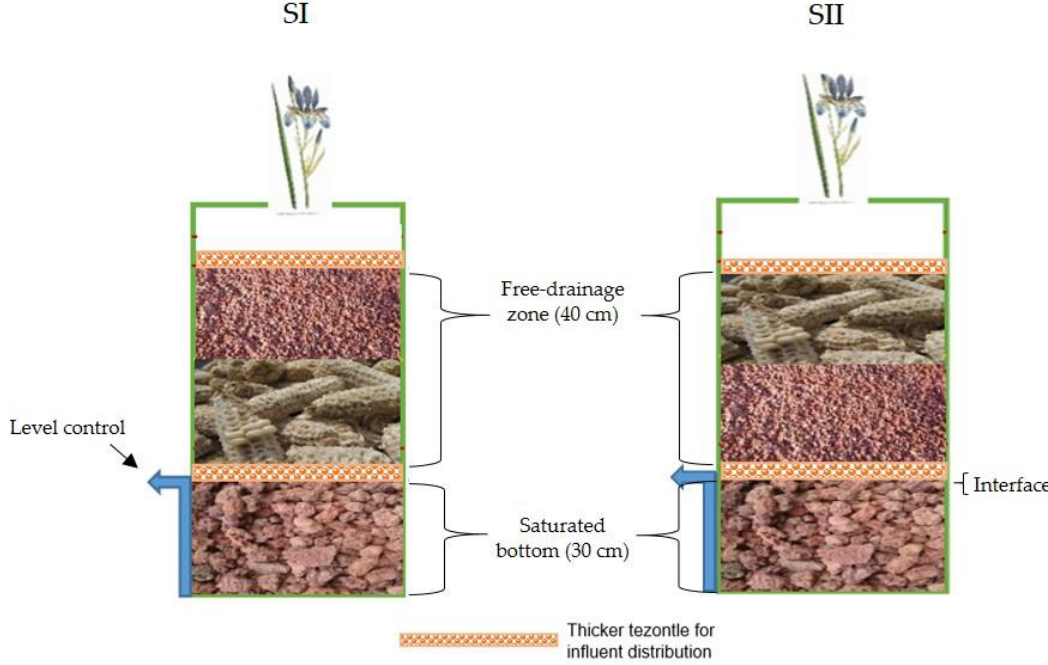
Figure 1. Two pilot-scale partially saturated (PS) vertical flow (VF) wetlands for nitrogen removal.